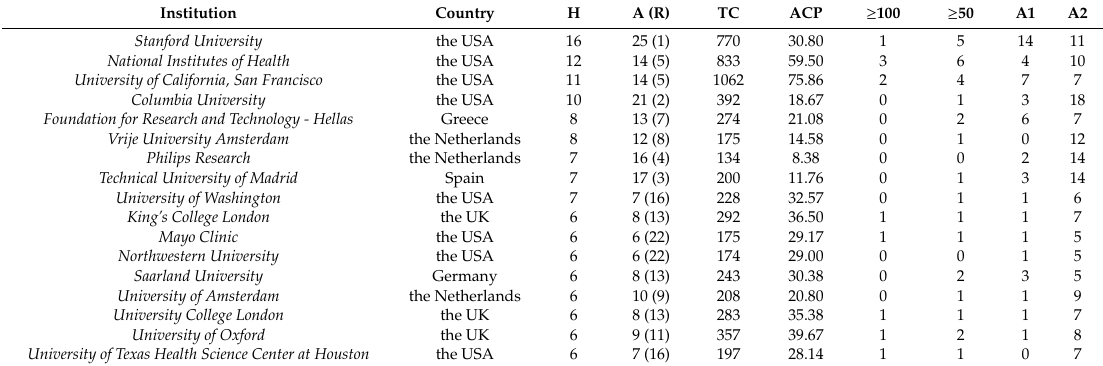
Abbreviations are the same as Table 5.